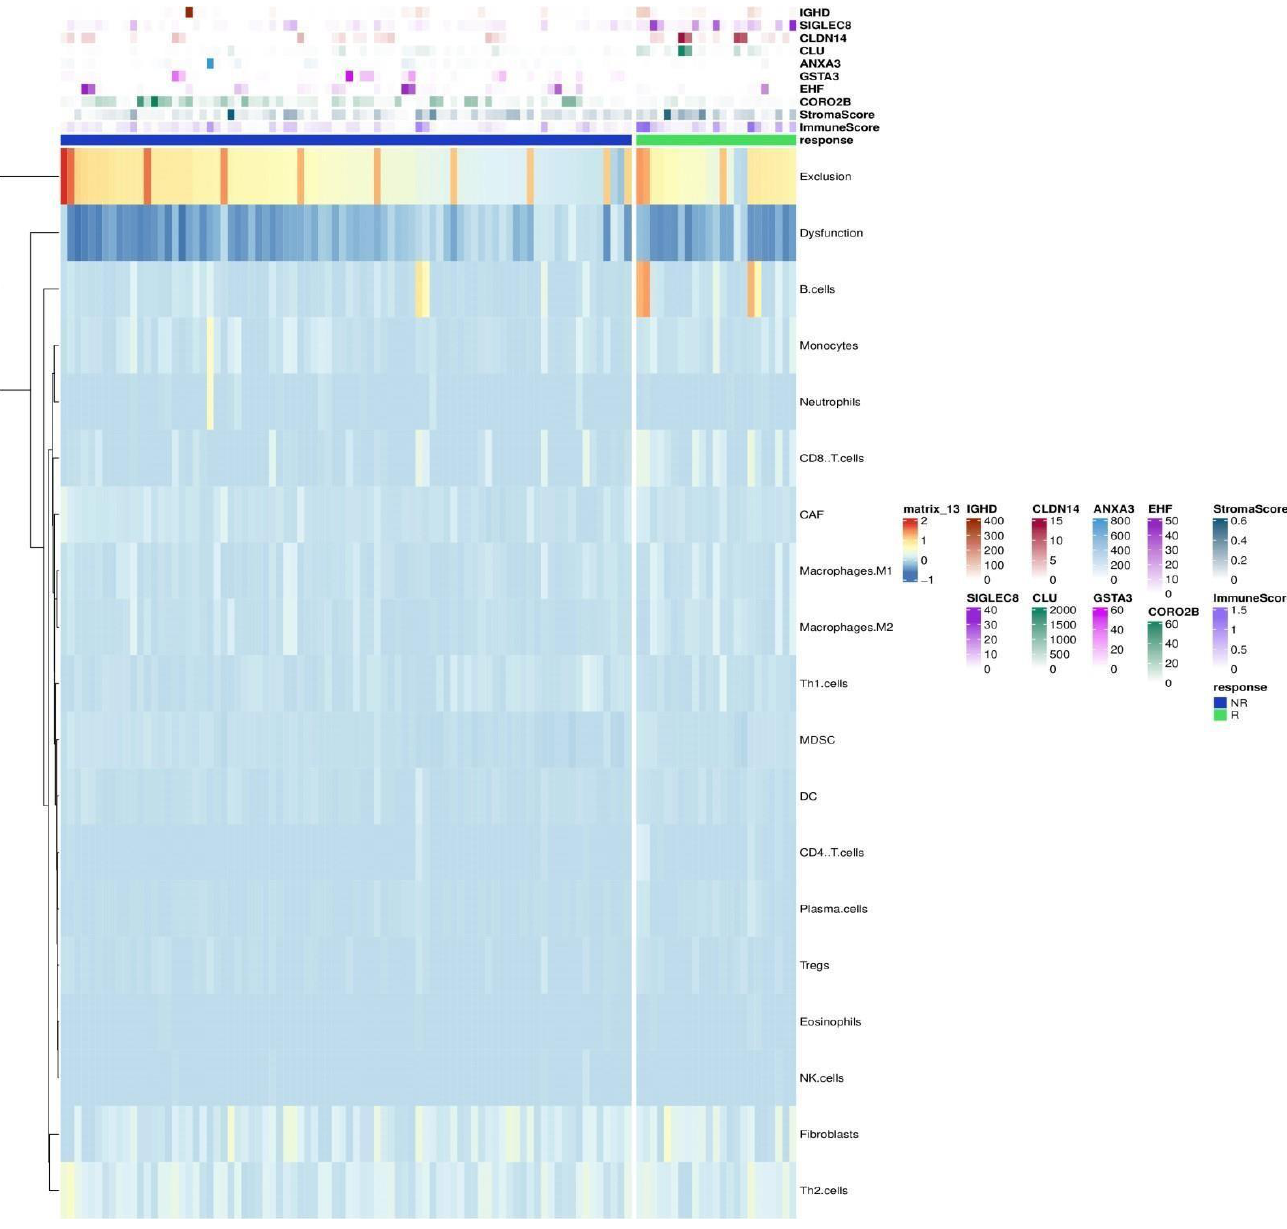
Figure 4. Heatmap of top DEGs and TME based on response to ICI. Top rows show the top 4 upregulated (IGHD, SIGLEC8, CLDN14, and CLU) and the top 4 downregulated (ANXA3, GSTA3, EHF, and CORO2B) genes based on SVM-RFE in the responders and non-responder patients’ groups. Rest of the rows show the landscape of